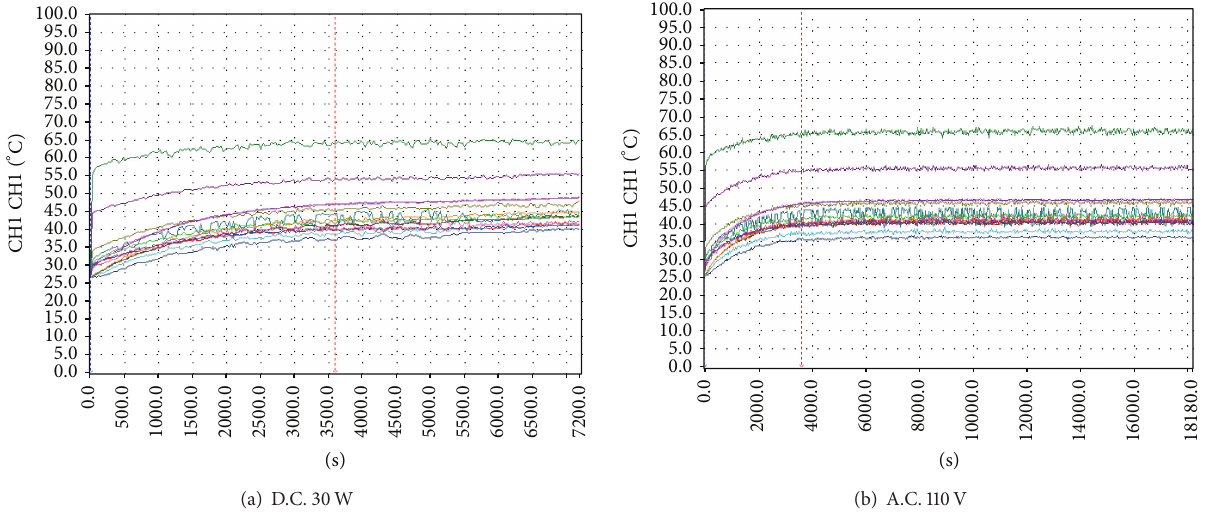
Figure 6: Temperatures with